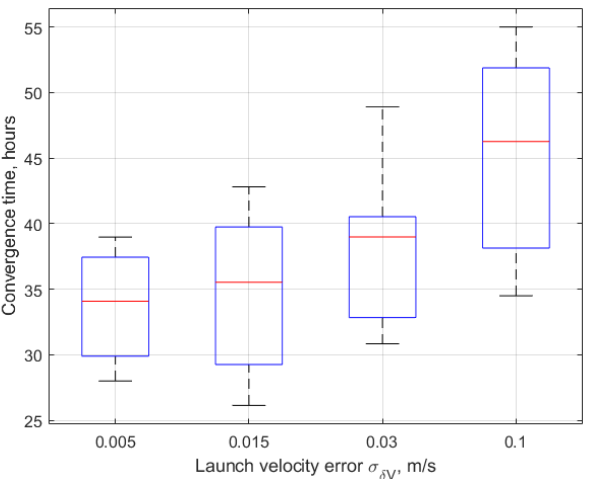
Figure 11. The dependence of the time of tetrahedron construction on the standard deviation of the launch velocity.